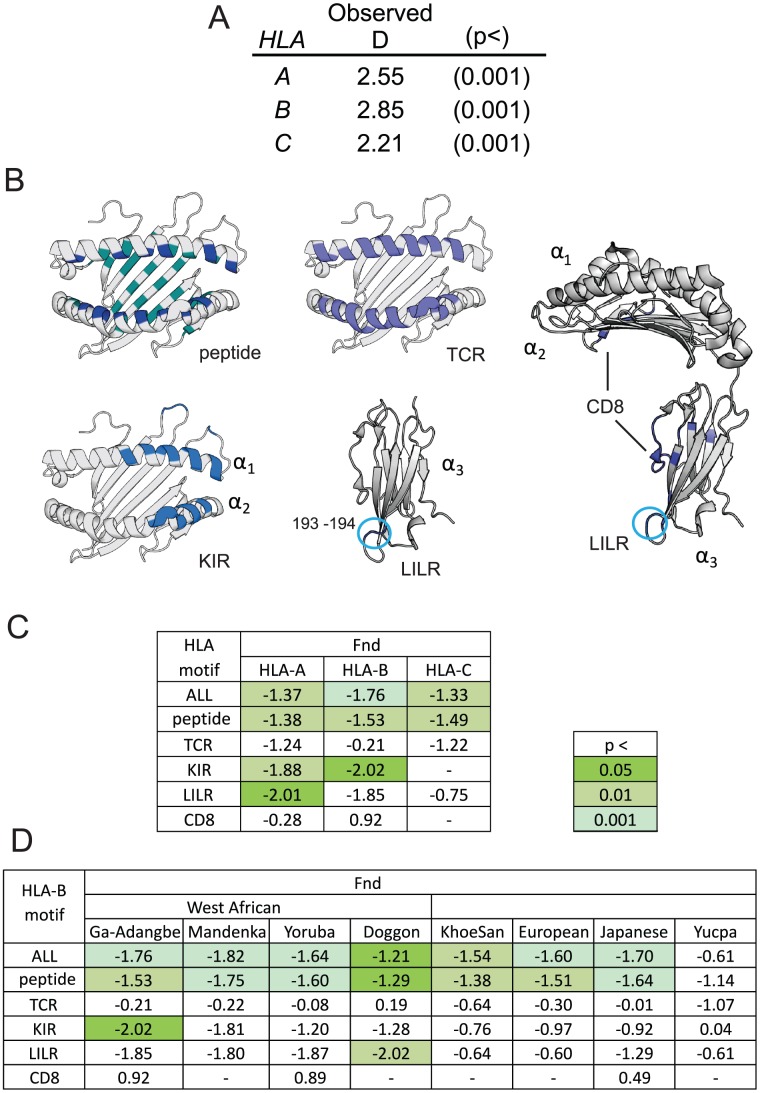
Robust footprint of balancing selection characterizes HLA-class I alleles in Ghana.A. Shown are values for Tajima's D generated from the nucleotide sequences of the HLA-A, -B and -C alleles present in the Ga-Adangbe. Significance values are from a two-tailed test comparing observed values to those obtained from 10,000 coalescent simulations, under a range of demographic models (p<0.001 for all models). B. The binding sites for lymphocyte receptors (in blue) on a 3D structure of HLA class I (PDB ref. 3SKO). For the peptide binding motifs, the residues that form the B and F anchor pockets (P2P9) are shown in a lighter blue. The LILRB1 binding domain is ringed. Relative orientation of the three domains is shown at the right. C. Shown are the normalized deviate values of Ewens-Watterson's F test (Fnd
[63]) for motifs of HLA-class I that interact with immune accessory molecules. ‘All’ - complete polypeptide sequence. For peptide-binding, TCR, KIR, LILR and CD8, only the residues exclusive to their respective motifs were included. (-) indicates motif is monomorphic. The KIR3DL2 binding sites of HLA-A are unknown. p values were calculated using the exact test described by Slatkin [98]. D. Shown are the Fnd values for accessory molecule-interacting motifs of HLA-B in West African and other populations chosen to represent major worldwide groups.